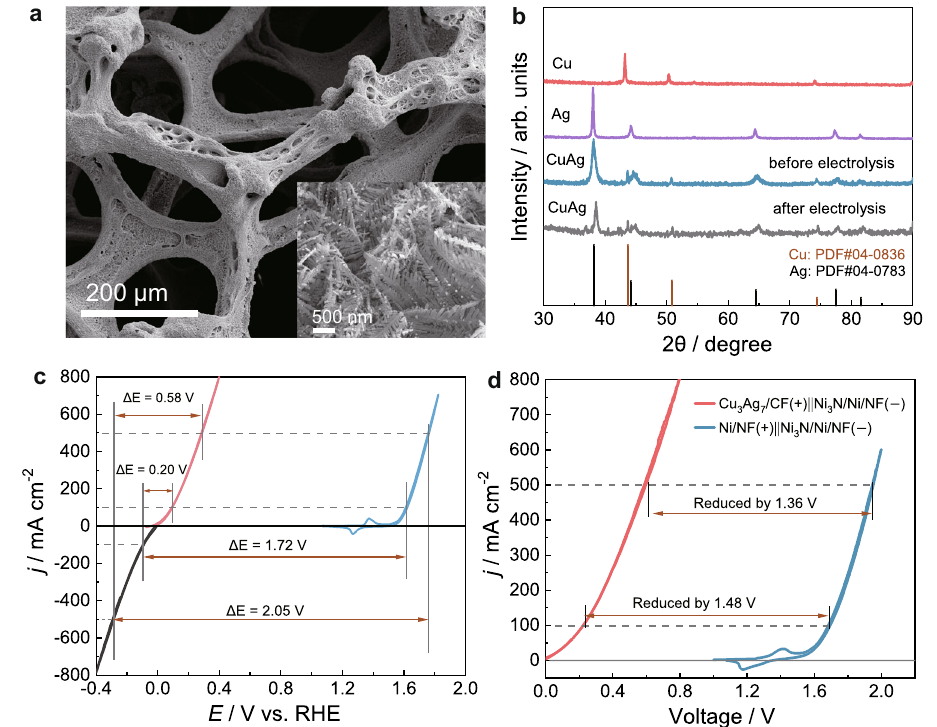
Fig. 3 | Characterizations and HCHO oxidation performances of Cu 3 Ag 7 /CF electrocatalysts.a SEMimageofas-preparedCu 3 Ag 7 /CF. b XRDpatternsofCu/CP, Ag/CP, and Cu 3 Ag 7 /CP prior to and post electrolysis. c CV curves of Cu 3 Ag 7 /CF for HCHO oxidation(red)in 1.0M KOH with 0.6M HCHO, Ni 3 N/Ni/NF for HER (black), and Ni/NF for OER (blue) in 1.0M KOH collected at 10mV/s. Voltage gaps to reach